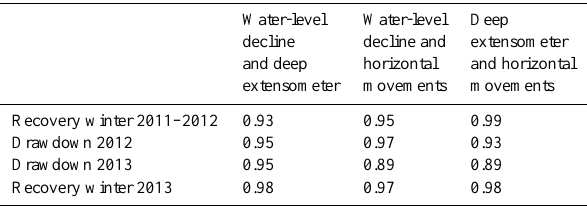
Table 1. Coefficients of determination for periods of recovery and drawdown for water-level fluctuations, deep extensometer com- paction, and horizontal movements. Water-level Water-level Deep decline decline and extensometer and deep horizontal and horizontal extensometer movements movements Recovery winter 2011–2012 0.93